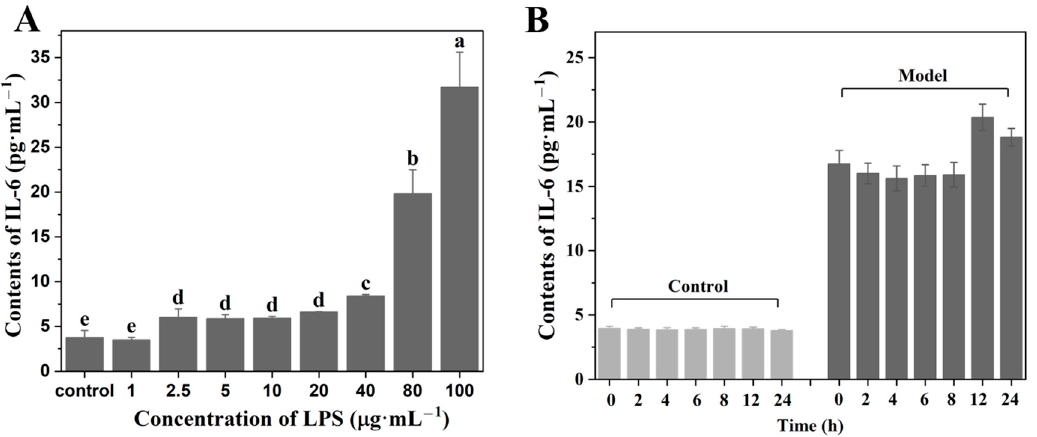
Figure 3. Contents of IL-6 on HaCaT cells of different concentrations of LPS treatment ( A ) and different durations of LPS treatment ( B ). a–e Values with different letters are significantly different ( p < 0.05).